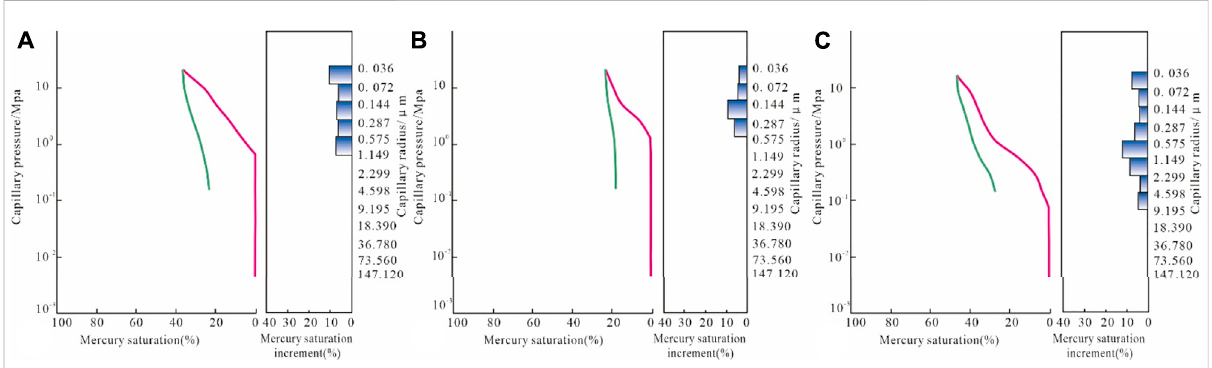
FIGURE 6 Capillary pressure curve of the Permian Upper Wuerhe reservoirs of Dinan 15 well block. (A,B) Capillary pressure curve of Section I reservoirs of the Upper Wuerhe Formation; (C) Capillary pressure curve of Section II reservoirs of the Upper Wuerhe Formation.